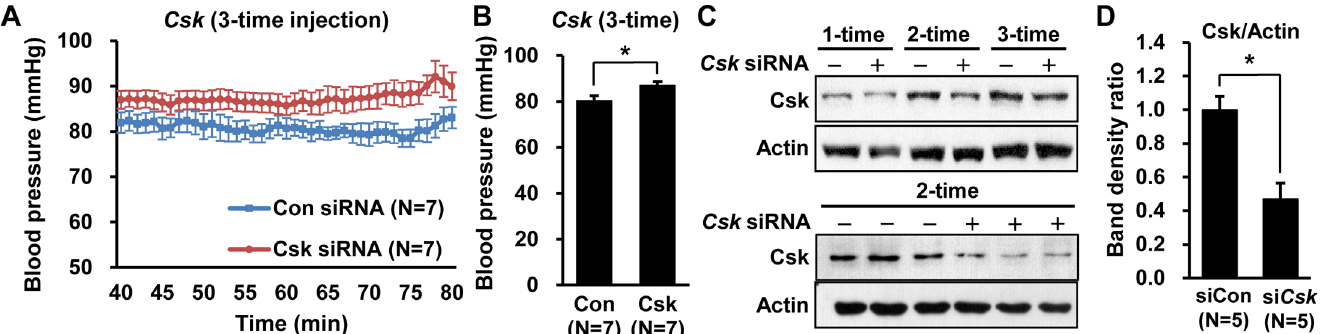
Fig 3. Increase in blood pressure in 3-time Csk siRNA-injected mice and change in protein levels in Csk siRNA-injected mice. (A) The line graph and (B) the bar graph show blood pressure from 40 min to 80 min after anesthesia in 3-time Csk siRNA-injected mice. (C) Csk protein levels in lung are shown for 1-, 2-, and 3-time siRNA injected mice following Western blotting. (D) Csk protein levels in lung are presented as the ratio of 5 independent protein band densities for 2-time siRNA injected